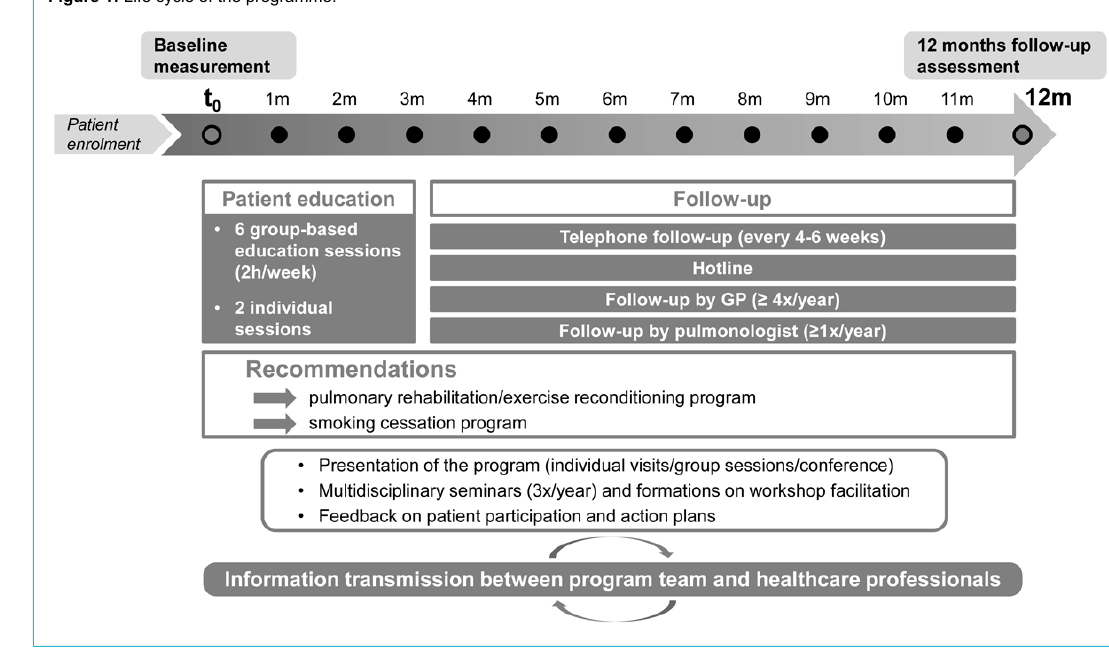
Figure 1: Life cycle of the